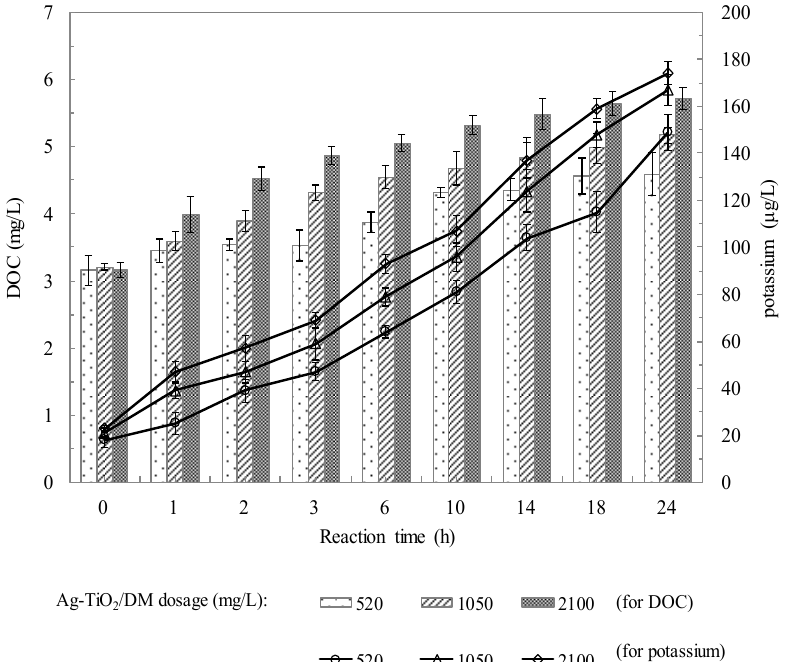
Figure 8. The concentrations of DOC and potassium ion as a function of photocatalytic reaction time.